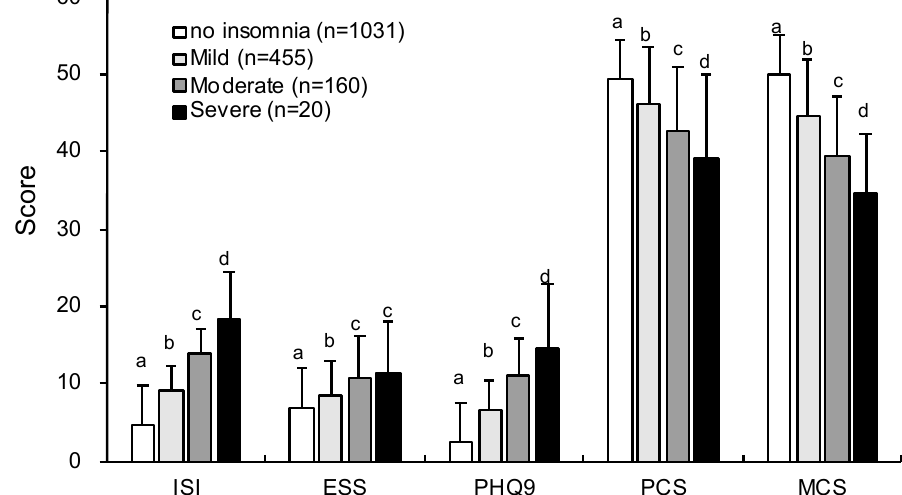
Figure2. ComparisonofcategoriesforinsomniaseverityaccordingtotheAISoneachscale. Differentletters Int. J. Environ. Res. Public Health 2020 , 17 , x FOR PEER REVIEW Figure 2. Comparison of categories for insomnia severity according to the AIS on each scale. Different indicate significantly different scores between groups ( p < 0.05). letters indicate significantly different scores between groups ( p < 0.05).